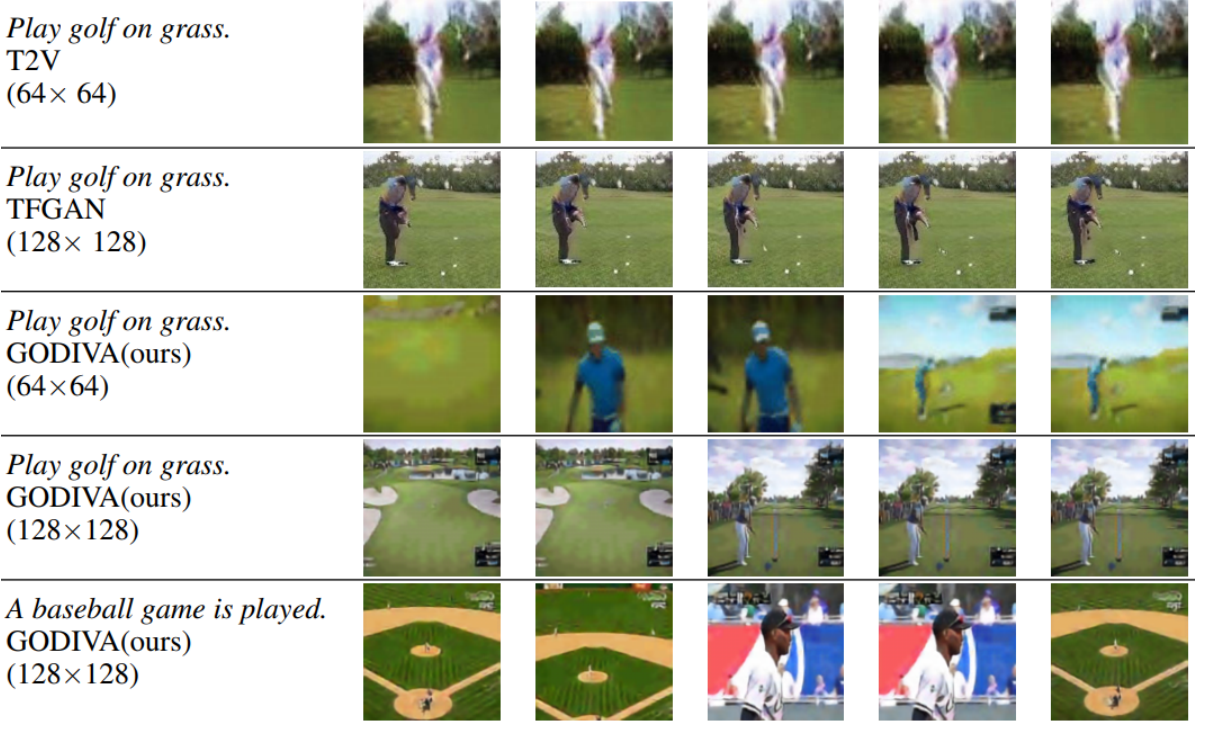
Figure 11. Reproduced from [254] on MSR-VTT